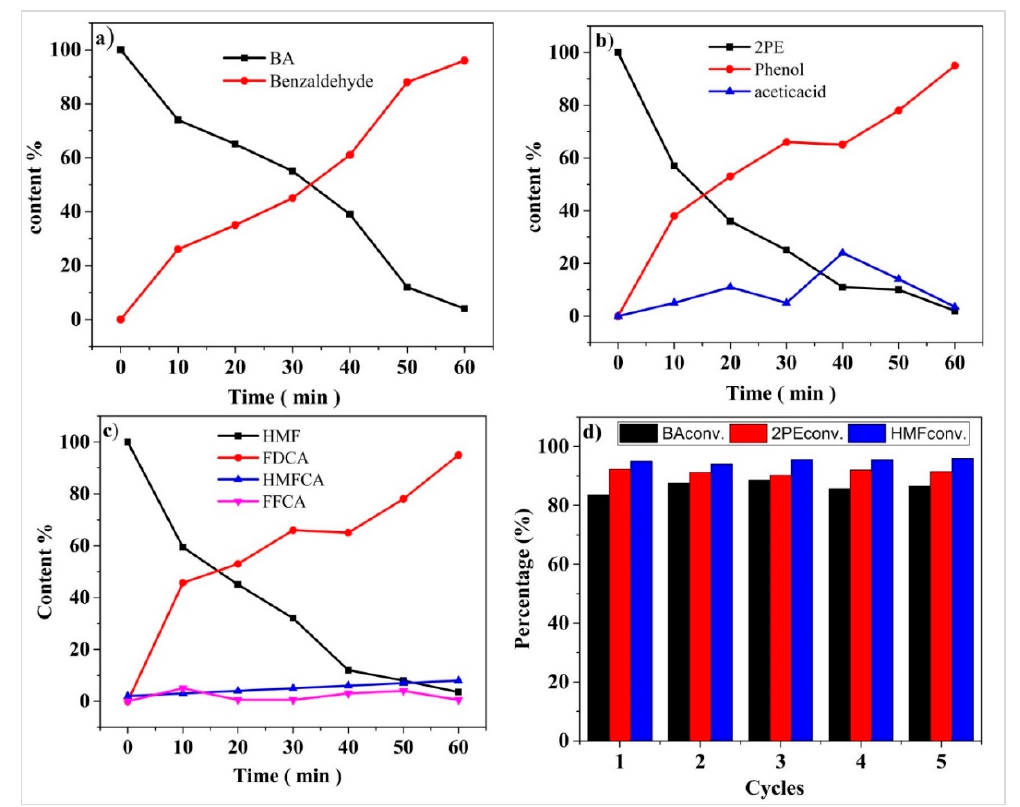
Figure 5. Evolution of reactant substrate and product concentrations for ( a ) BA, ( b ) 2-PE, and ( c ) HMF. ( d ) Effect of recycling on the electrocatalytic oxidation of CoP@NiF for the conversion of different substrates. Table 4. Comparison of electrochemical oxidation of alcohol using various electrocatalyst.